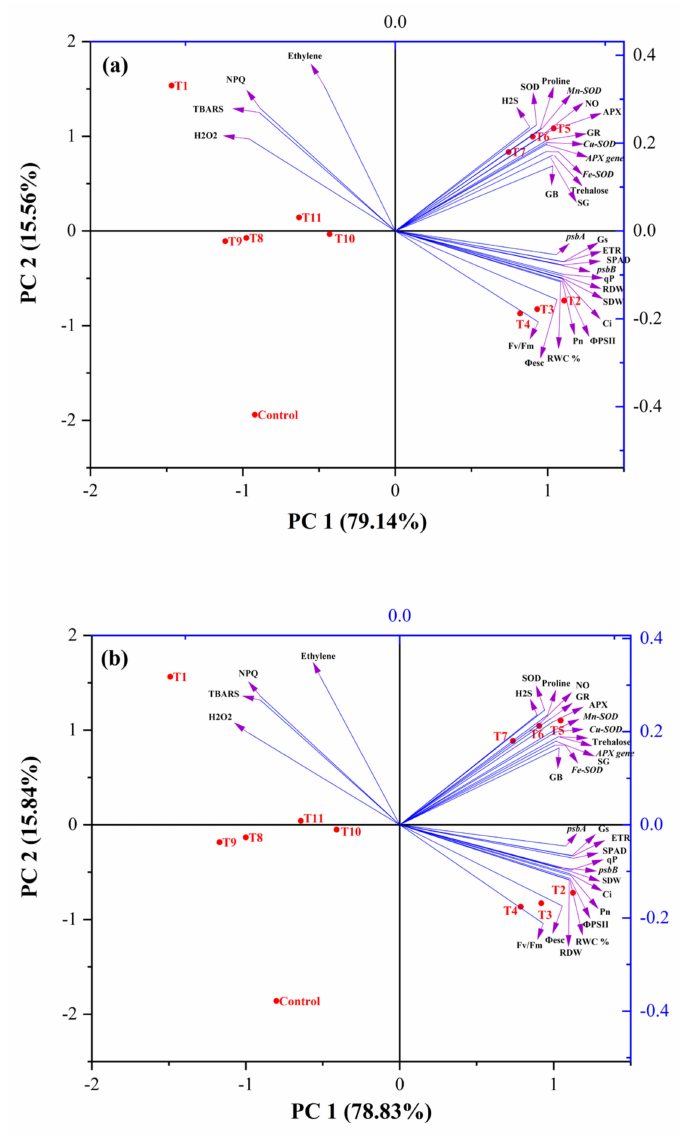
Figure 6. Biplots of principal component analysis (PCA) represents the relationship among differ- ent treatments and variables of two rice cultivars, Taipei-309 ( a ) and Rasi ( b ) grown under differ- ent conditions such as control, high temperature stress; HS (T1), Eth; Eth (T2), sodium nitroprus- side; SNP (T3), sodium hydrosulfide; NaHS (T4), HS + Eth (T5), HS + SNP (T6), HS + NaHS (T7), HS + Eth + hypotaurine; HT (T8), HS + SNP + HT (T9), HS + NaHS + norbornadiene; NBD (T10), and HS + NaHS + 2-4-carboxyphenyl-4,4,5,5 -tetramethylimidazoline-1-oxyl-3-oxide; cPTIO (T11). The variables included H 2 O 2 (hydrogen peroxide), TBARS (thiobarbituric acid reactive substances), non- photochemical quenching (NPQ), ethylene evolution, SOD (superoxide dismutase), APX (ascorbate peroxidase), GR (glutathione reductase) activity, gene expression of ( Mn-SOD , Cu-SOD , Fe-SOD , and APX ), contents of H 2 S (hydrogen sulfide), NO (nitric oxide), proline, trehalose, SG (soluble sugar) and GB (glycine betaine), gene expression of psbA and psbB , Pn (net photosynthesis), Gs (stomatal conductance), Ci (intercellular CO 2 concentration), SPAD value, Fv/Fm (maximum efficiency of PSII), Φ PSII (actual efficiency of PSII), Φ esc (intrinsic efficiency of PSII), qP (photochemical quenching), NPQ (non-photochemical quenching), ETR (electron transport rate), RDW (root dry weight), SDW (shoot dry weight), and RWC% (relative water